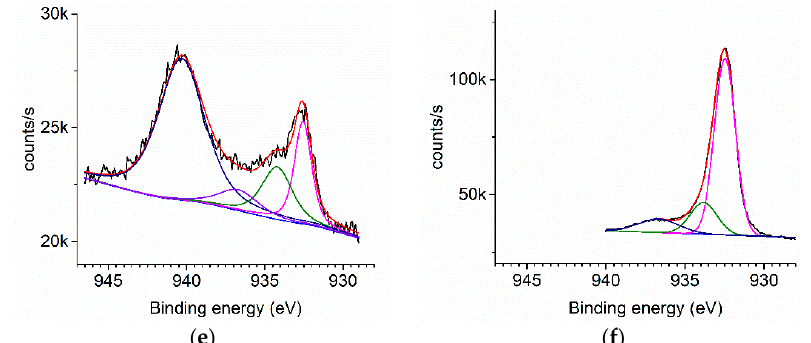
Figure 5. XPS Cu 2 p peaks, uncapped quartz samples: ( a ) Q7 500 c. and Q10 1000 c., unsputtered; ( b ) Q7 500 c. and Q10 1000 c., Ar-sputtered; ( c ) decomposed 2 p 3/2 peak, Q7, unsputtered; ( d ) decomposed